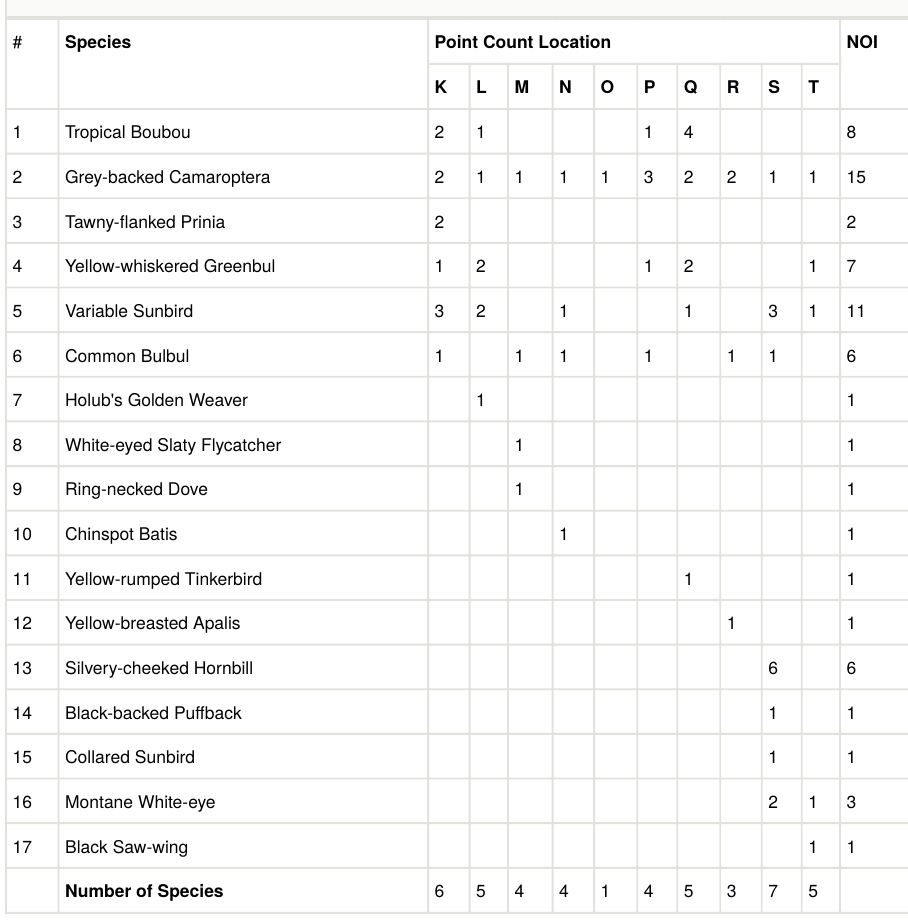
Table 3. Results of the point count on 28th January, 2016. The number of individuals (NOI) observed at various locations